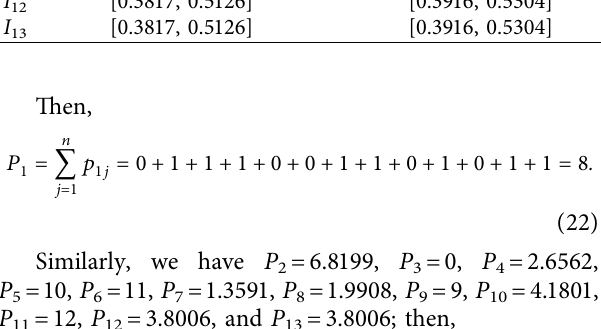
Table 3: Interval information content of I